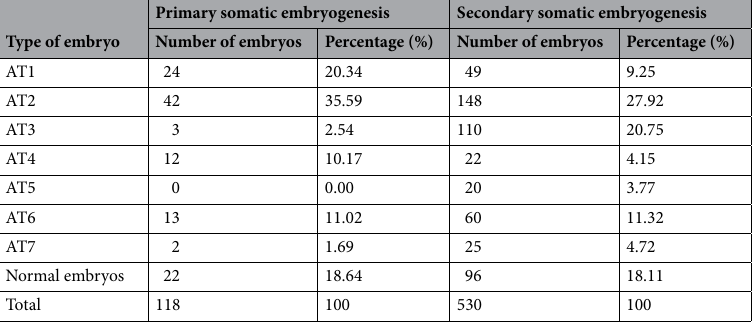
Number of embryos Percentage (%)